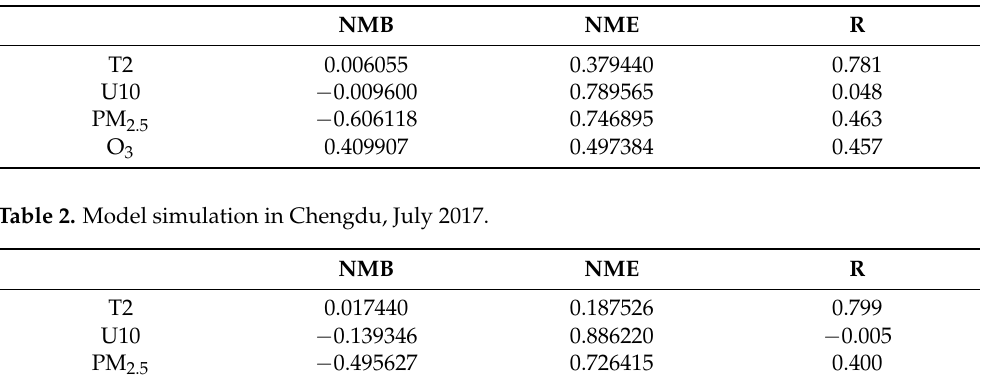
Figure 3. Time series of temperature at 2 m (T2), wind speed at 10 m (U10), PM 2.5 and O 3 concentra- tion in Chengdu in July 2017. Black is the observed value and orange is the simulated value. Table 1. Model simulation in Chengdu, January 2017.